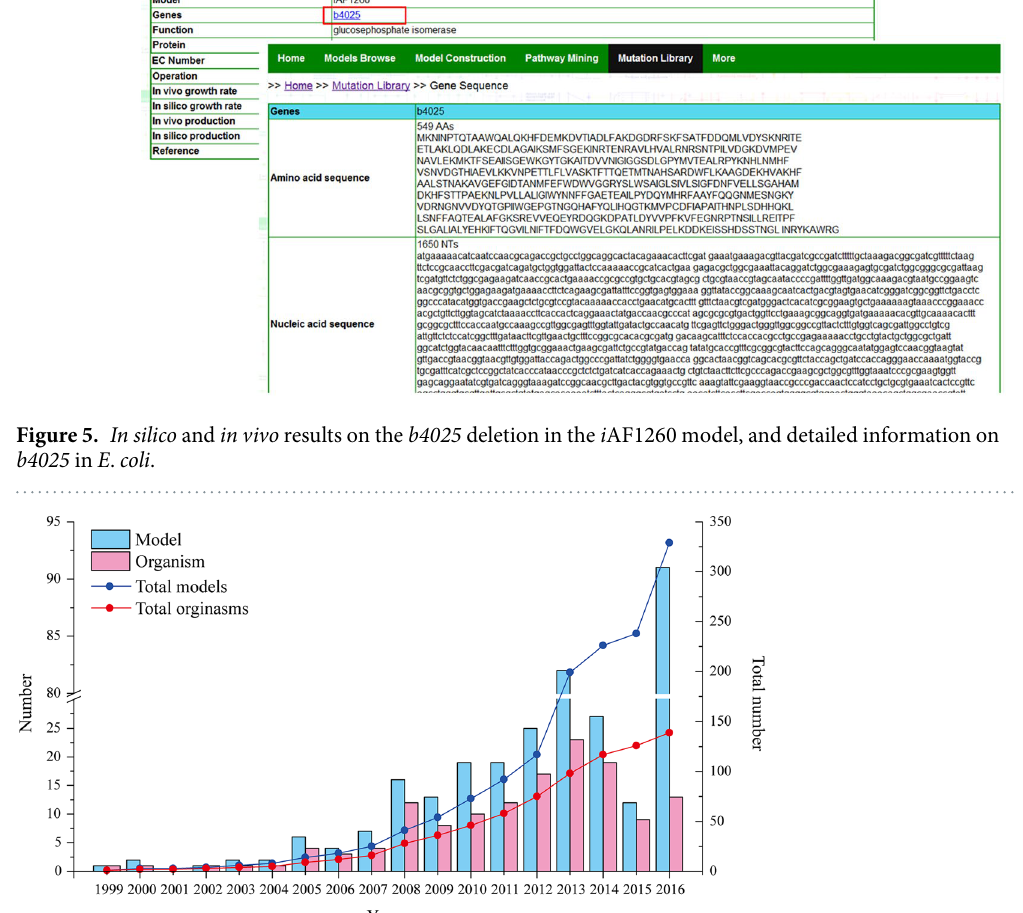
glucose as carbon source galactose as carbon source growth rate strain wide type